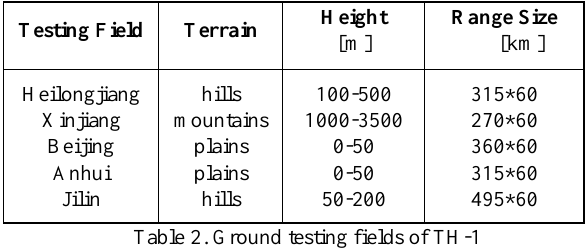
Table 2. Ground testing fields of TH-1